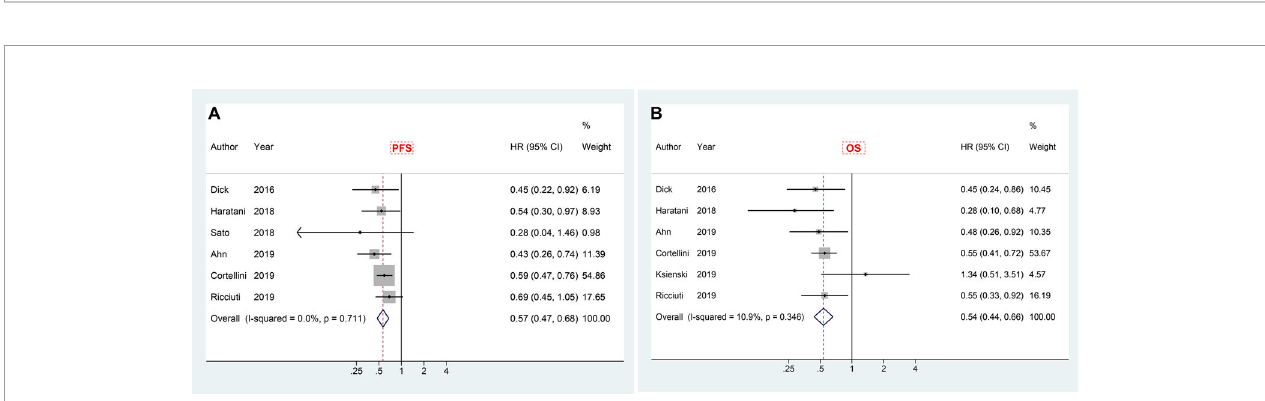
FIGURE 4 | Forest plot of the association of immune-related adverse events with overall survival (OS) in cancer patients receiving immune checkpoint inhibitors. HR, hazard ratio; CI, con fi dence interval.